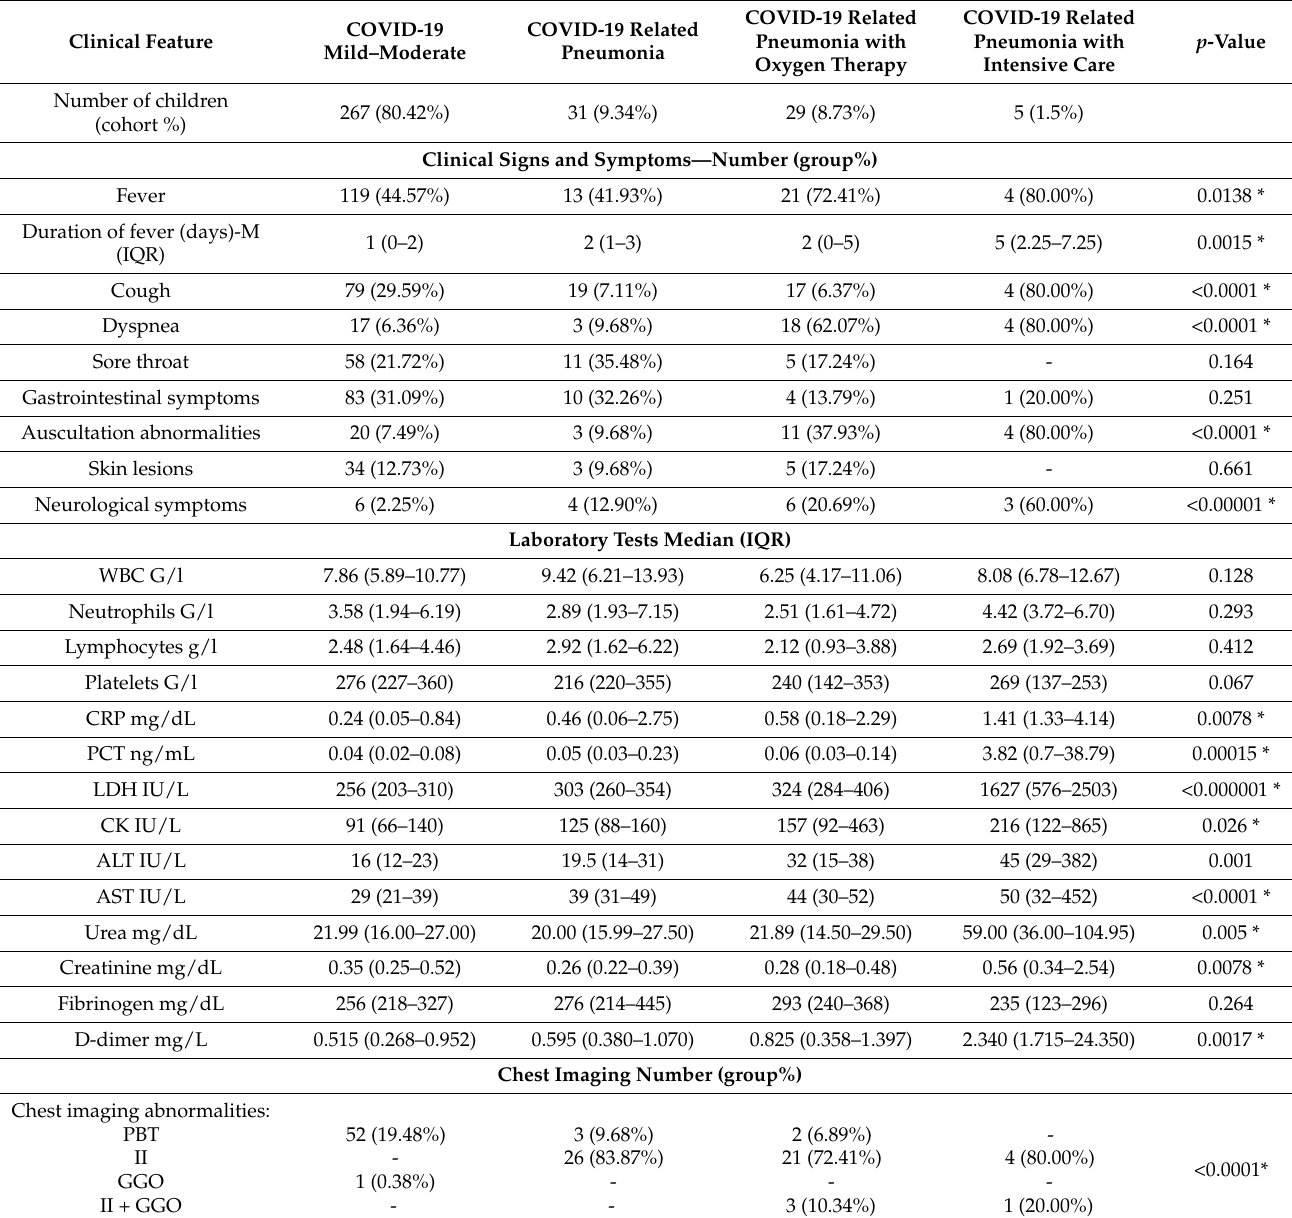
Table 2. Clinical symptoms and laboratory findings in children with COVID-19 concerning the severity of